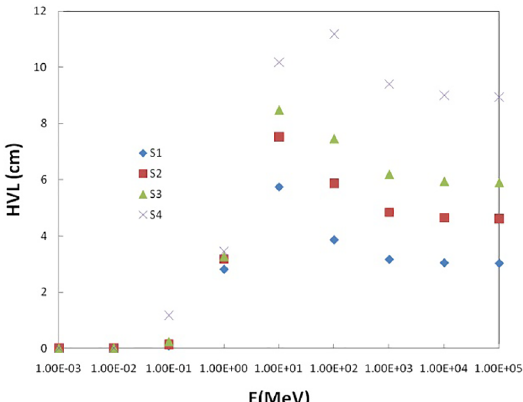
Figure 1. Plot of HVL (cm) for various samples as a function of photon energy Table 4. Chemical Compositions of Concretes